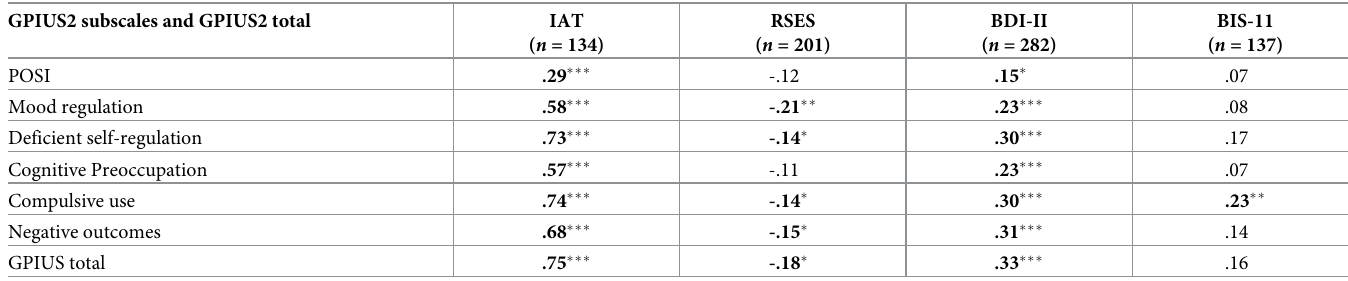
Table 4. Partial correlation coefficients between the GPIUS2 scales and IAT, self-esteem, depression, and impulsivity, with age as a covariate. GPIUS2 subscales and GPIUS2 total